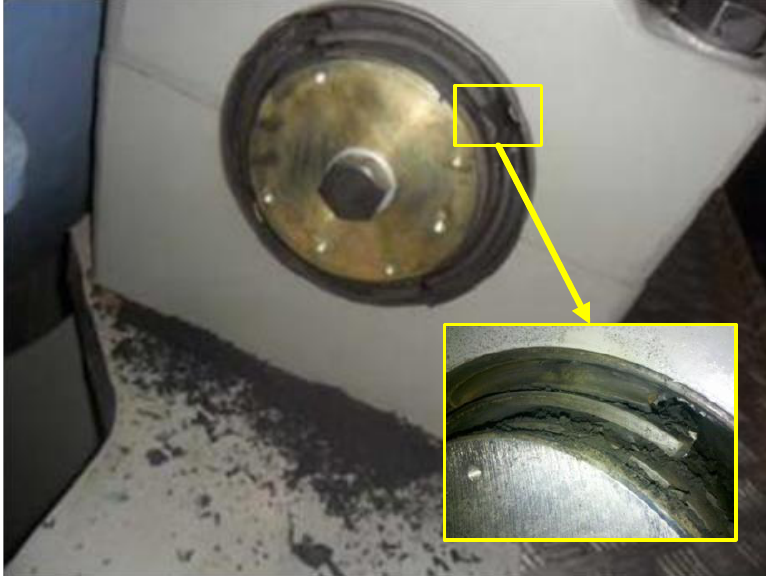
Figure 10. Main bearing offset failure. Table 7. Datasets of main bearing offset failure.